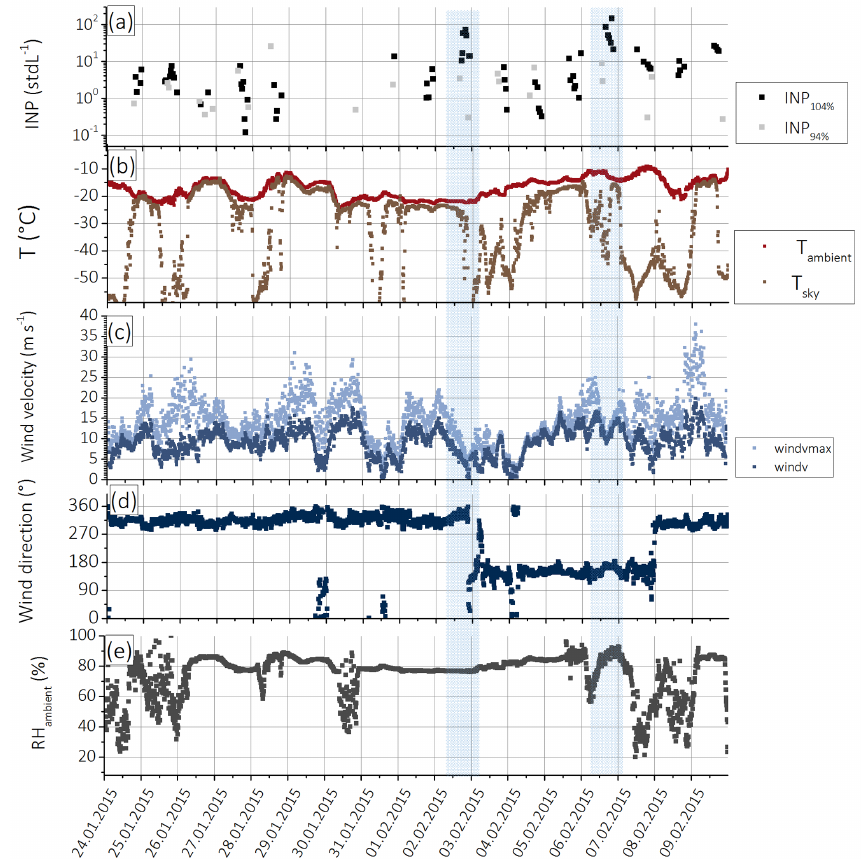
Figure B1. Time series of meteorological data, taken by MeteoSwiss: (a) INP concentrations at 242K and RH w = 104 and 94% as measured with HINC; (b) ambient temperature ( T ambient ) and sky temperature ( T sky ) (Herrmann et al., 2015); (c) hourly maximum wind velocity (windmax) and wind velocity (windv); (d) wind direction; (e) ambient relative humidity (RH ambient